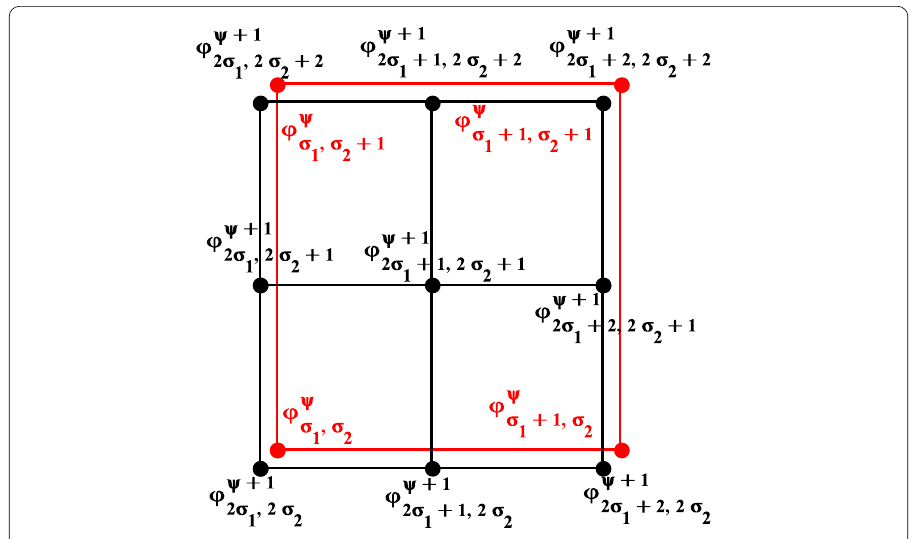
Figure 1 Subdivision of a surface patch by using GTPBRS